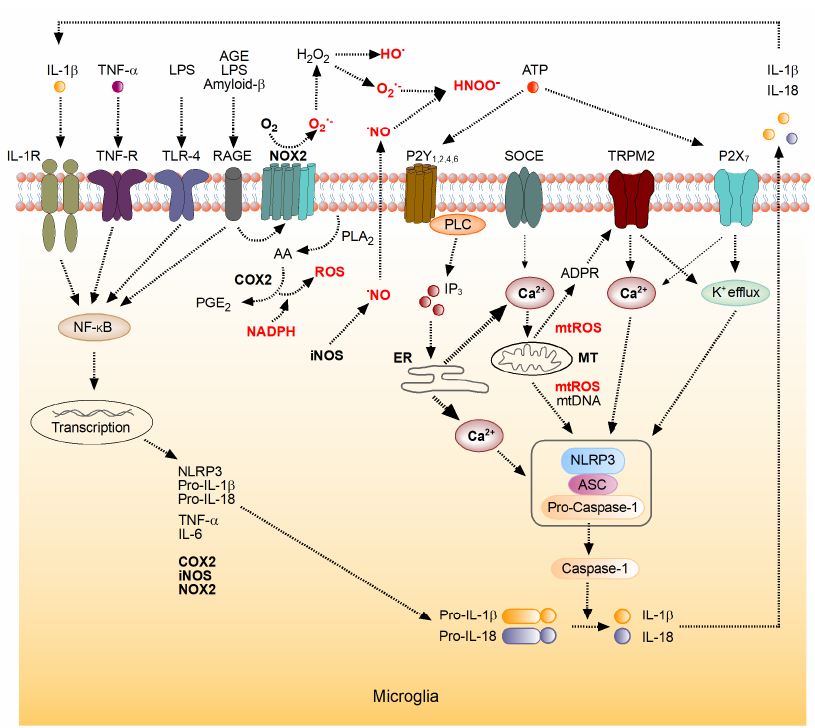
Figure 1. Molecular mechanisms underlying microglial reactive oxygen species (ROS) metabolism. Mechanisms involved in the interplay between the inflammation-mediated ROS production, increases in [Ca 2+ ] i and cytokine production by microglia (see text for detailed description). IL-1 β ,